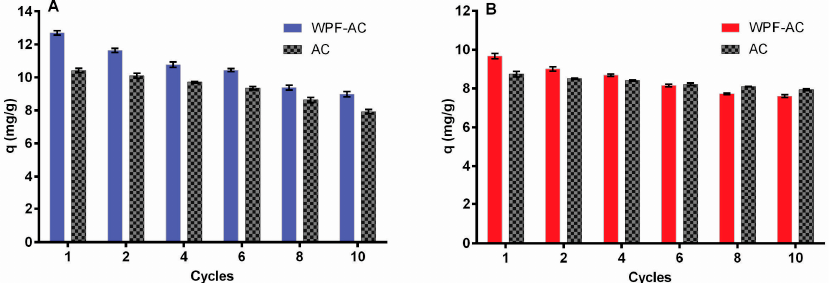
Figure 7. Comparison of the adsorption capacity per filtration cycle of the hybrid membrane and AC alone using adsorbate solutions with initial concentration of 50 mg/L. ( A ) Adsorption capacity per cycle of filtration for mercury; ( B ) adsorption capacity per cycle of filtration for chromium. Error bars represent the standard deviations ( n = 3).